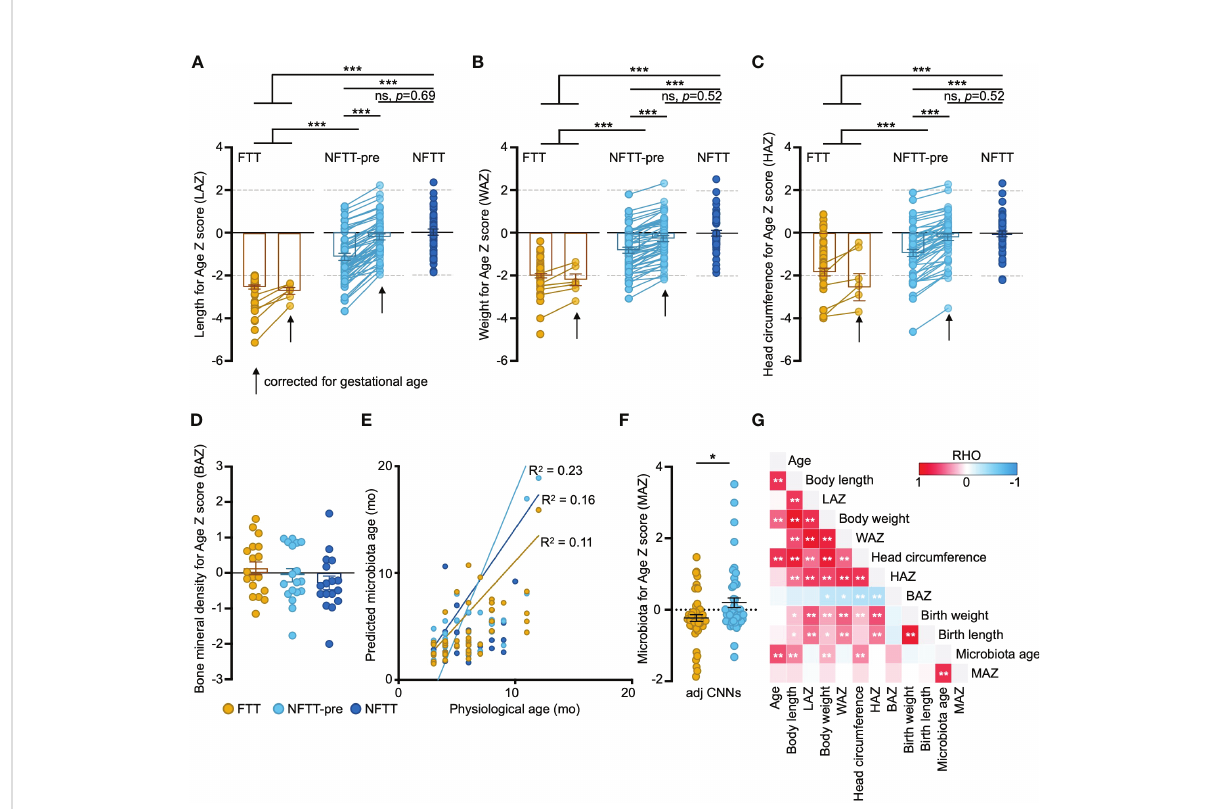
FIGURE 1 Anthropometric features in FTT are related to the development of gut microbiota. (A-D) Anthropometry features in FTT, NFTT-pre, and NFTT groups. Mean values ± SEM are plotted. One-way ANOVA, *** p < 0.001. (E) . Predictions of microbiota age in the FTT, NFTT-pre and NFTT subjects, respectively. Each circle represents an individual fecal sample, and the curves are smoothed linear fi t between microbiota age and chronological age. (F) Microbiota for Age Z score (MAZ) in the FTT and NFTT-pre groups. Mean values ± SEM are plotted. One-way ANOVA, * p < 0.05. (G) The heatmap of the correlations between the gut microbiota developmental descriptive features and host anthropometry features. Based on Spearman ’ s correlation coef fi cient, * p < 0.05, ** p <